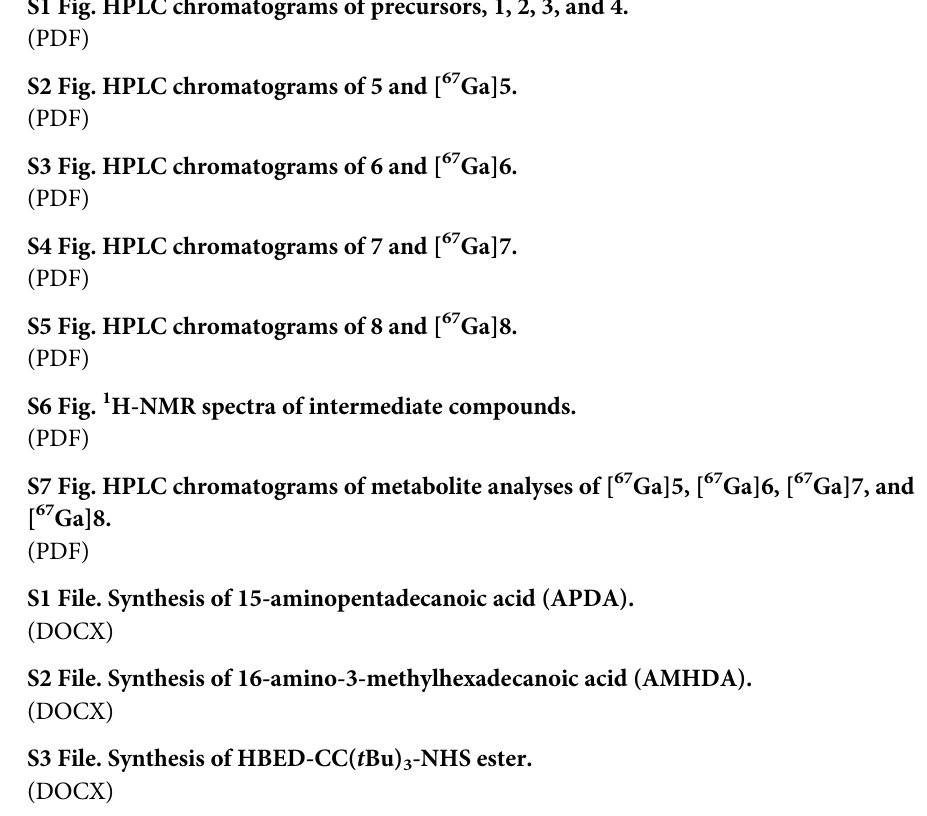
S2 Fig. HPLC chromatograms of 5 and [ 67 Ga]5.